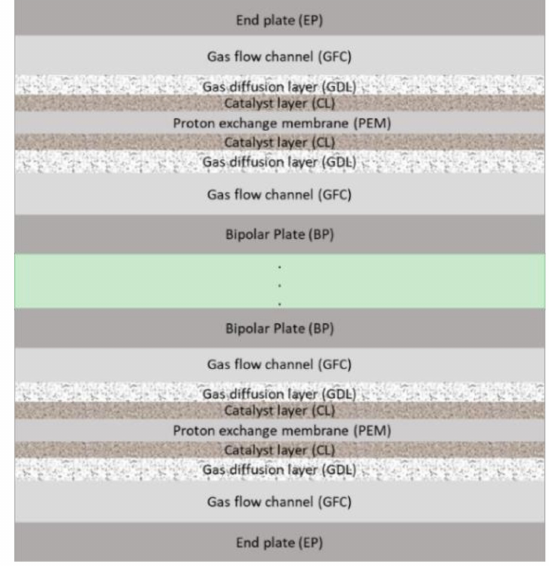
Figure 4. The structure of a PEMFC